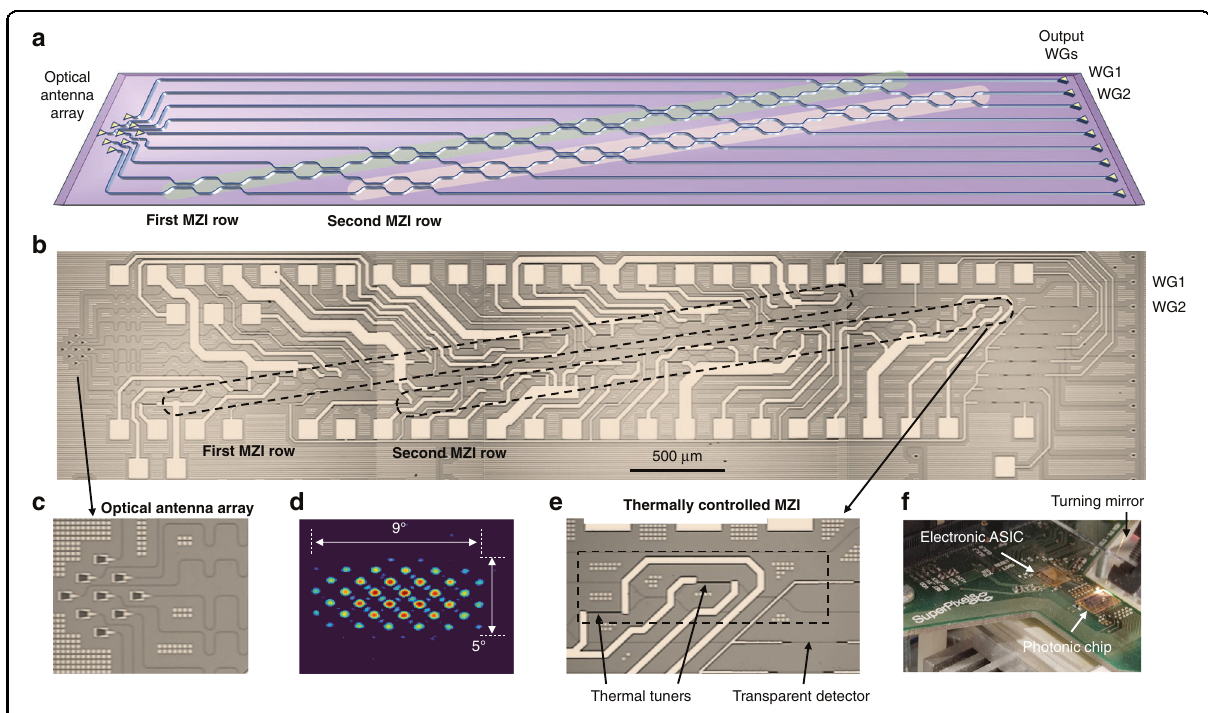
Fig. 1 Multibeam FSO Receiver. a Schematic of a 9 × 2 diagonal photonic processor comprising two rows of tunable MZIs and implementing a two-beam FSO receiver. The 2D optical antenna array is used to couple free-space beams into the silicon waveguides, while the output ports WG1 and WG2 are used to couple the light out to a pair of optical fi bers. b Microscopic picture of the fabricated silicon chip. c Detail of the 2D optical antenna array made of 3 × 3 grating couplers in a square con fi guration. d Measured far- fi eld pattern radiated by the 2D optical antenna array when all the grating couplers are excited with the same amplitude and phase. Multiple diffraction orders (grating lobes) are visible within the 5° × 9° angular beamwidth of the radiation pattern of the elementary grating coupler. e Detail of a thermally tunable beam coupler with a transparent monitor detector integrated at output ports. f Photograph of the photonic chip assembled on a PCB integrating the CMOS electronic ASIC for the read-out of on-chip